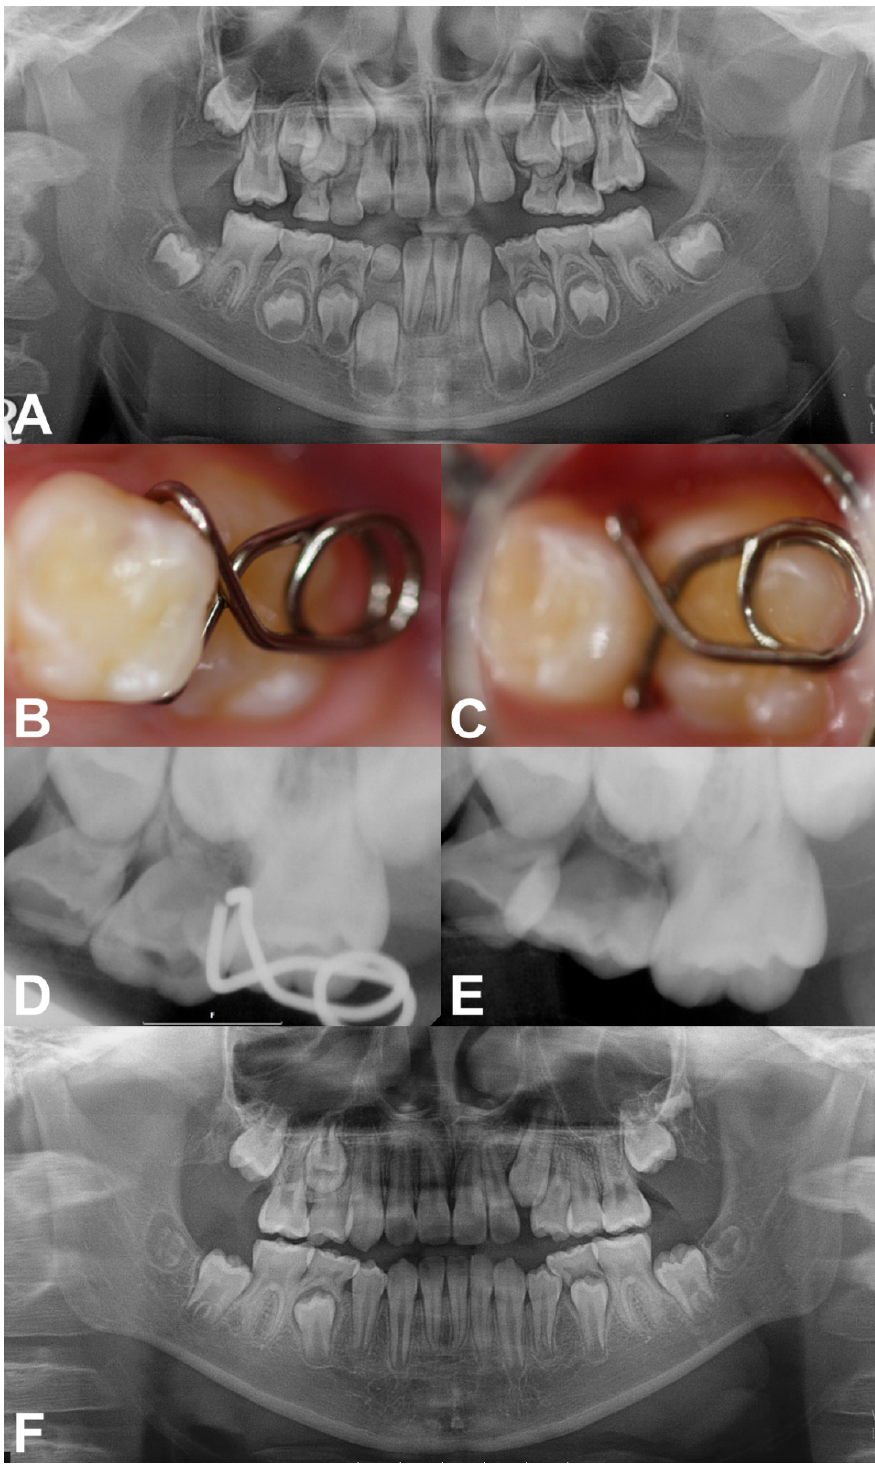
Figure 2. Pre-treatment and treatment progress images of case 1. ( A ) Pre-treatment panoramic radiograph at 7 years of age. ( B,C ) Clinical photograghs after the insertion of mRS. ( D ) Periapical radiograph obtained 1 month after delivery, showing relieved locking. ( E ) Post-treatment radiograph showing the successfully corrected left maxillary first molar with proper occlusion after 3 months. ( F ) Post-treatment panoramic radiograph taken at 9 years of age. Left maxillary premolars fully erupted without space